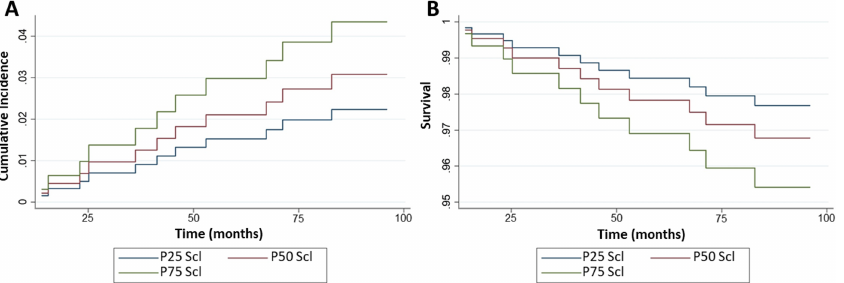
Fig 4. Cumulative incidence function and survival curve according to the quartiles of sclerostin for cardiovascular mortality. (A) Cumulative incidence of mortality from the Fine and Gray model and (B) Kaplan-Meier curve of the survival analysis from the proportional hazard model. The values of sclerostin are expressed as pmol/L x 10 units.